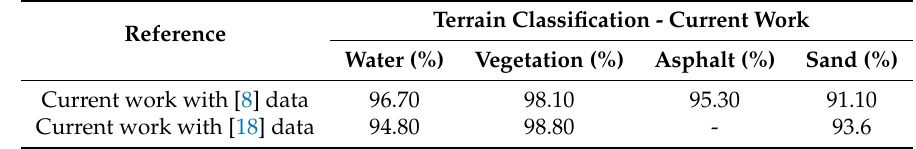
Table 4. Comparison between existing Terrain Classification Systems—Sorted by success